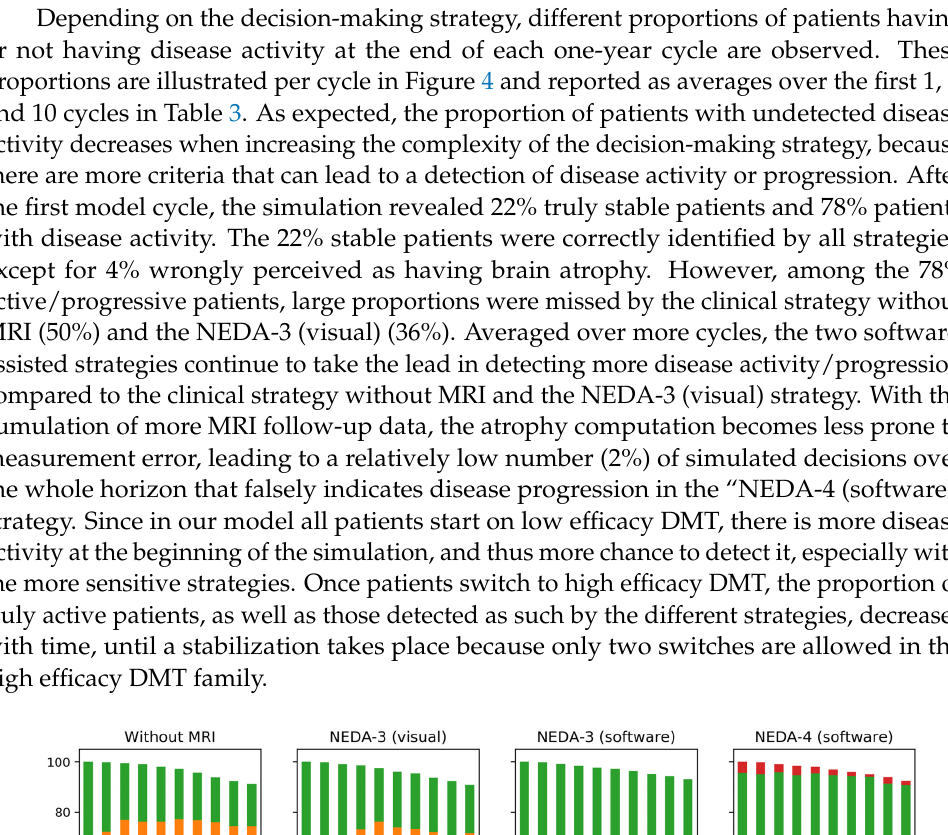
Table 3. The proportion of patients detected as stable or active in the four decision-making strategies. Results are reported for several model horizons, namely after the first cycle, and averaged over the first 5, and 10 cycles/years. No decisions are reported for patients who reached EDSS 7, but their respective proportions are listed for each strategy.